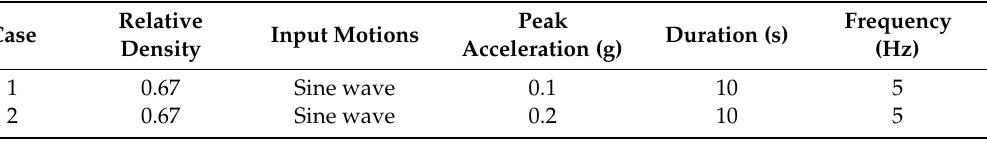
Table 3. Summary of shake table tests conducted.